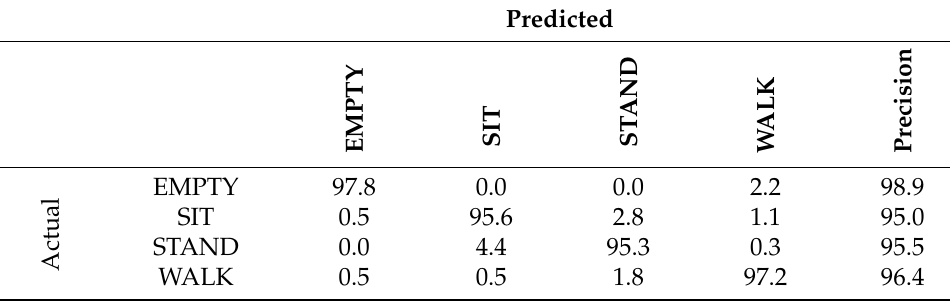
Table 3. Confusion matrix multiclass-SVM with Experiment 1.1.